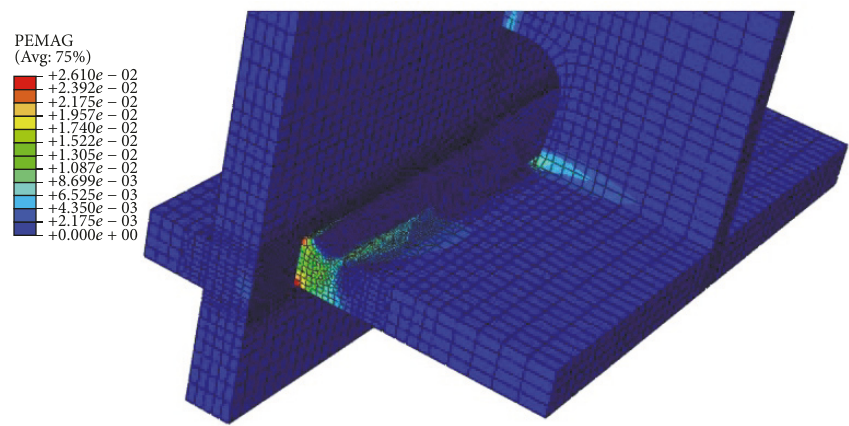
Figure 10: Plastic strain magnitude of the bottom flange weld at 𝑡 = 2.36 s.